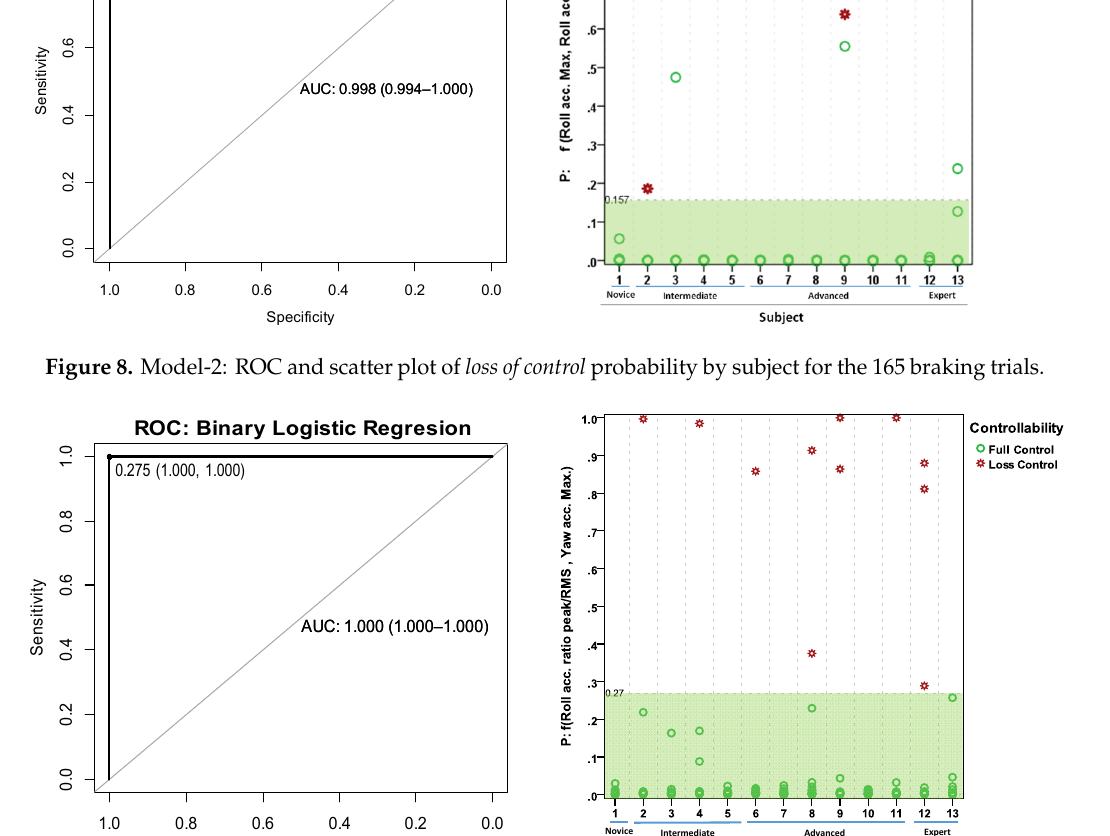
Table 3. Prediction Performance and best thresholds for the feature input. Predictor